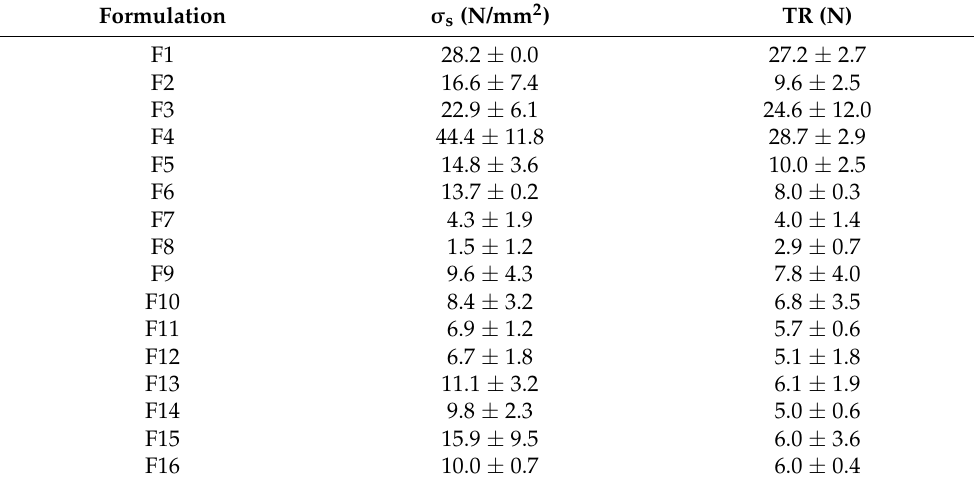
Figure 1. Mechanical properties of the films F1–F12 ( A ) and F13–F16 ( B ) expressed as Young’s modulus (E) (mean ± standard deviation (SD), n ≥ 3, p < 0.05). Formulations with the same polymer ratio and deposition order, but different LM PC type were indicated with the same color. Table 1. Mechanical properties of the films F1–F16 expressed as tensile strength ( σ s ) and tear resistance (TR) (mean ± SD, n ≥ 3, p < 0.05).